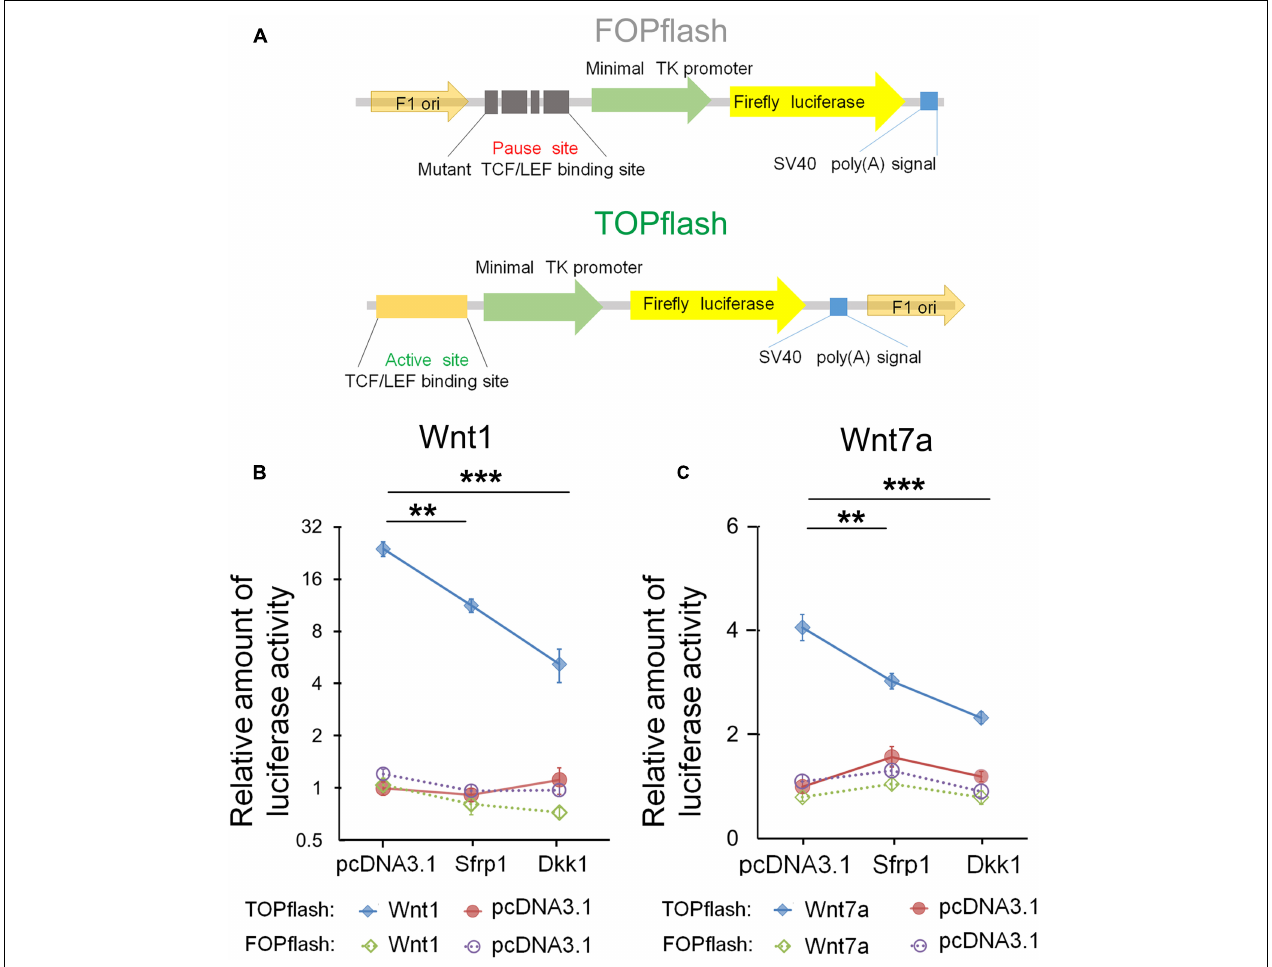
FIGURE 6 | Sfrp1 inhibits Wnt7a activity in the TOPflash luciferase reporter assay. (A) TOPflash is a luciferase reporter of β -catenin-mediated transcriptional activation with active TCF/LEF binding sites, which affect the firefly luciferase expression. The control plasmid is FOPflash , which contains mutant TCF/LEF binding sites. (B,C) After transfection of the pcDNA3.1 - Sfrp1 and pcDNA3.1 - Dkk1 , a statistically significant decrease in luciferase activity of Wnt1 and Wnt7a was observed in comparison with controls. Values represent mean ± SEM. n = 3, ∗∗ P < 0.01; ∗∗∗ P < 0.001; unpaired Student’s t